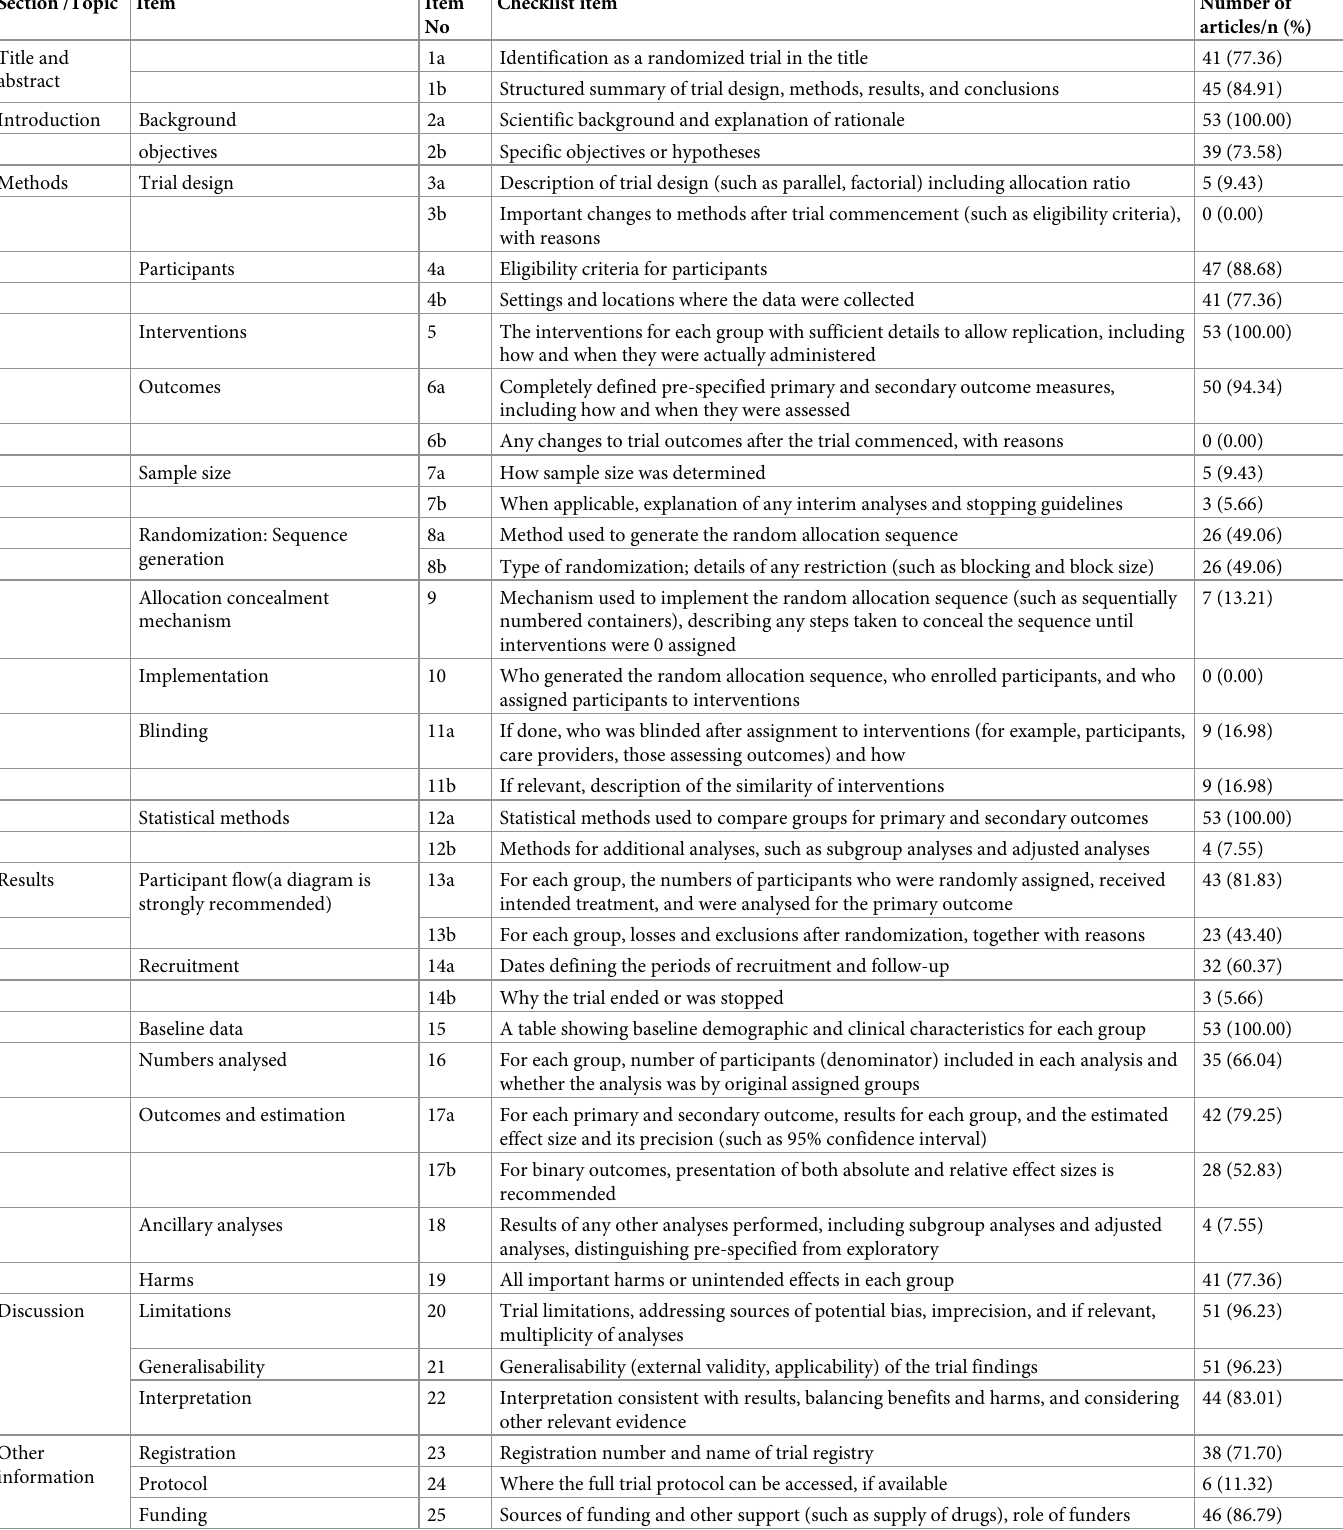
Table 2. The evaluation result of the CONSORT checklist. Section /Topic